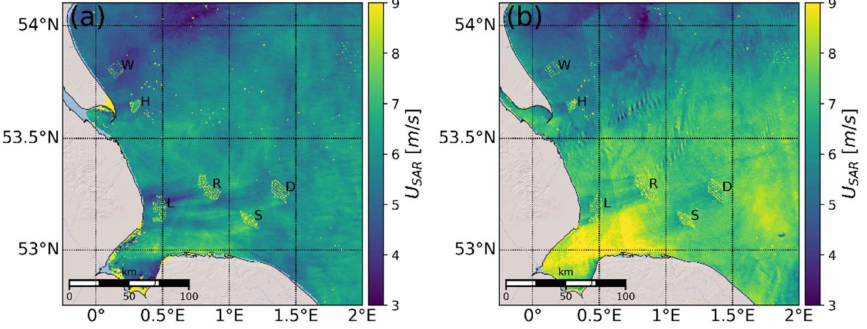
Figure 13. SAR wind retrieved at 500 m resolution for (a) Case 2, and (b) Case 3. Wind farms visible are: Westermost Rough (W), Humber Gateway (H), Lincs (L), Race Bank (R), Sherinham Shoal (S), Dudgeon